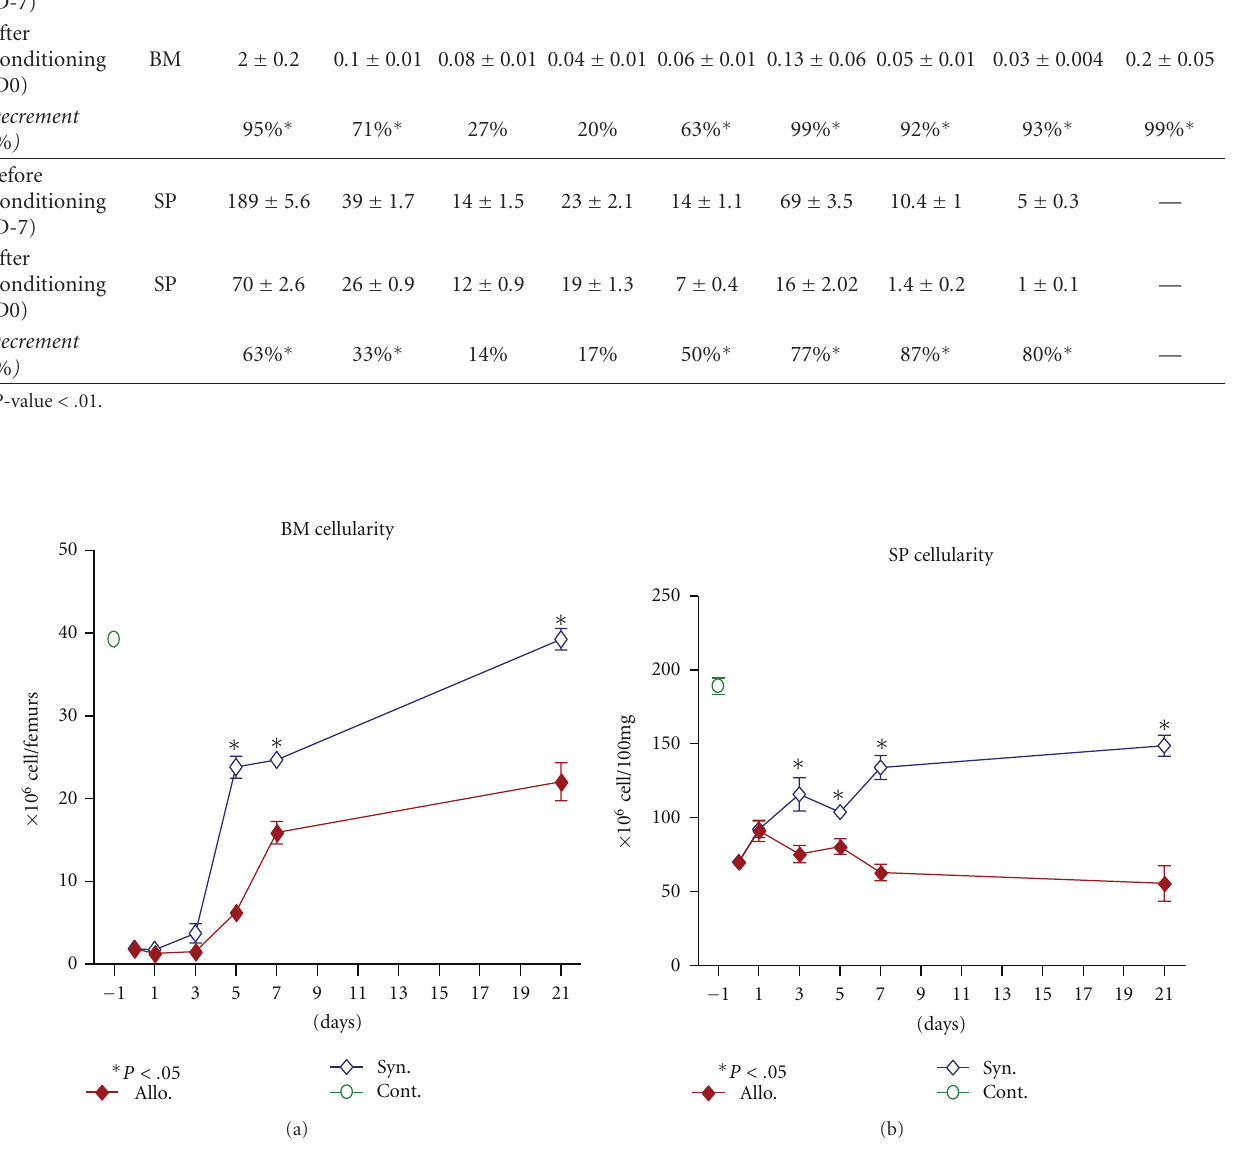
Figure 1: Bone marrow and spleen cellularity in allogeneic and syngeneic transplanted mice. Female BALB/c mice were transplanted with 20 × 10 6 and 30 × 10 6 BM and SP cells, respectively, from male C57BL/6 or BALB/c mice as allogeneic or syngeneic setting. Bone marrow (a) and spleen (b) cellularity at di ff erent time points after conditioning and transplantation. (a) Bone marrow cellularity calculated based on total cells extracted from both femurs. (b) Spleen cellularity determined based on 100 mg of spleen tissue. ( (cid:2) ): allogeneic group, ( ♦ ): syngeneic group and (O): control mice. All values are mean ± SE for 4 to 6 animals in each group per time point. Di ff erences were analyzed statistically employing U-test, compared between groups ( ∗ P < .